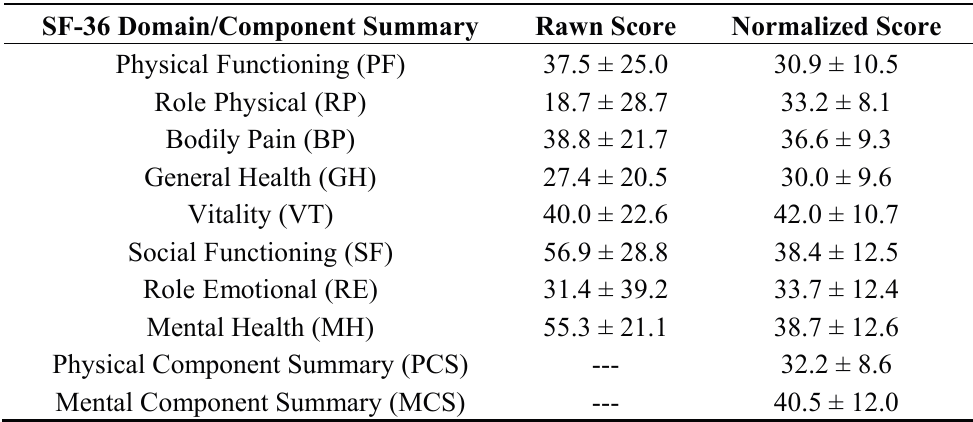
Table 1. SF-36 raw and normalized scores (mean ± SD) of 186 former lead workers from Santo Amaro da Purificação lead smelter, Brazil,